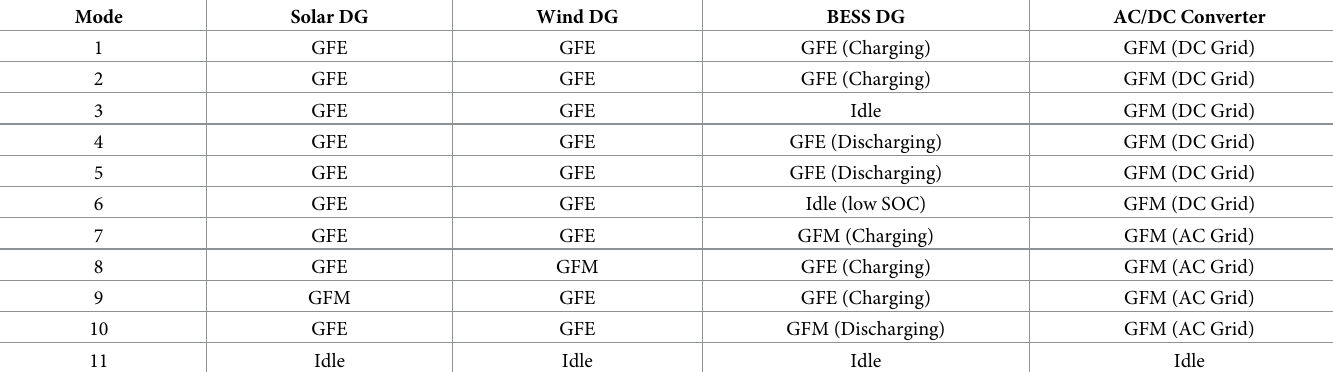
Table 3. Roles of power converters in all cases.